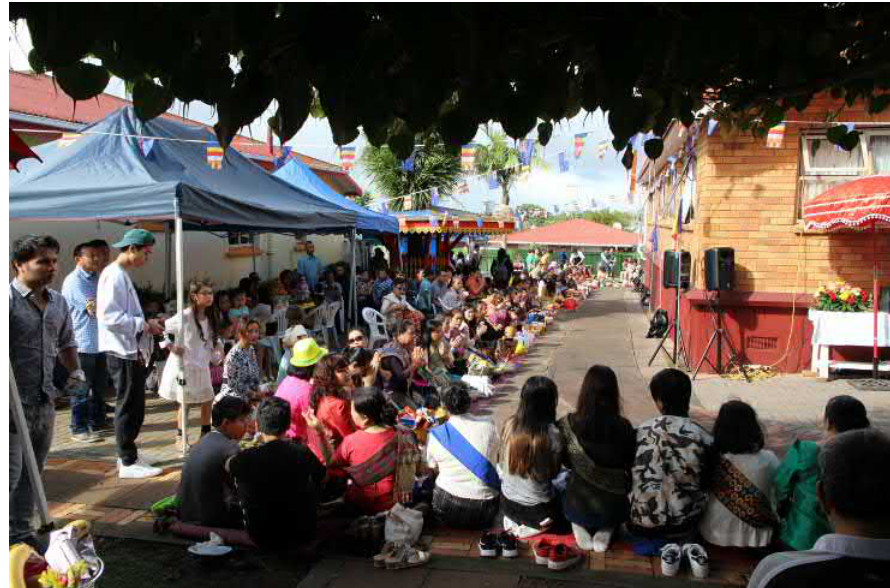
Figure 9: Laotian New Year celebrations in 2017: Wat Lao Buddharam, Ōtāhuhu, Auckland. (Photo by Vou Phommahaxay)